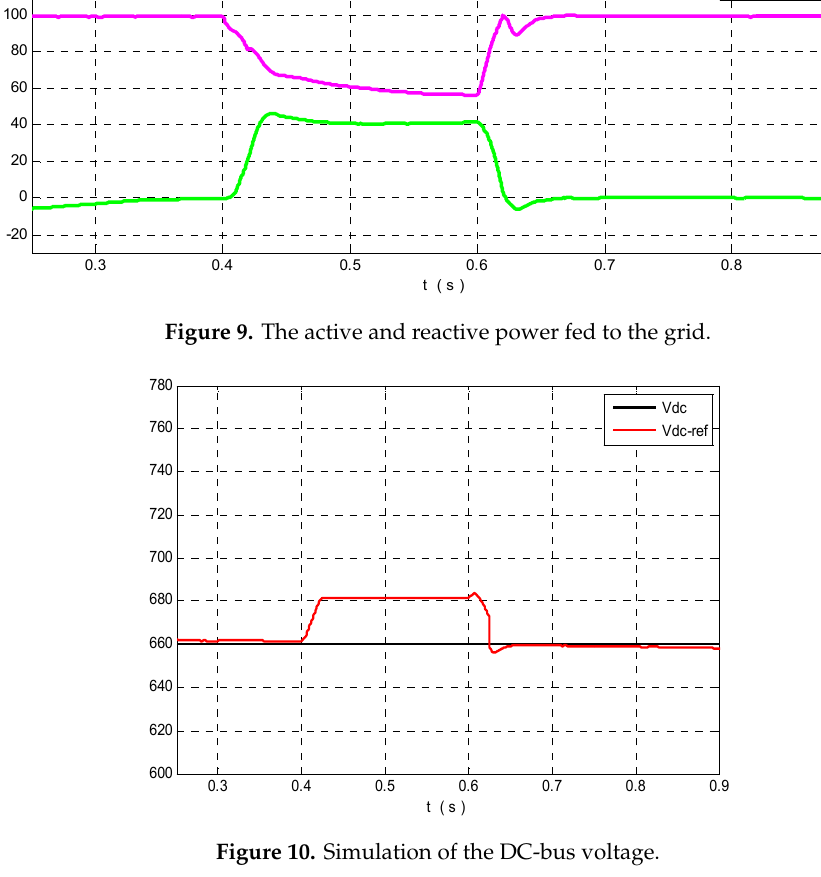
Figure 11. The grid voltages signals.